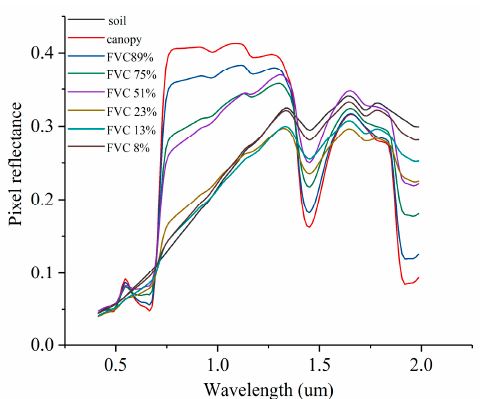
Figure 7. Mixed pixel spectra under different fractional vegetation covers (FVCs) (FVC of canopy is 100%).